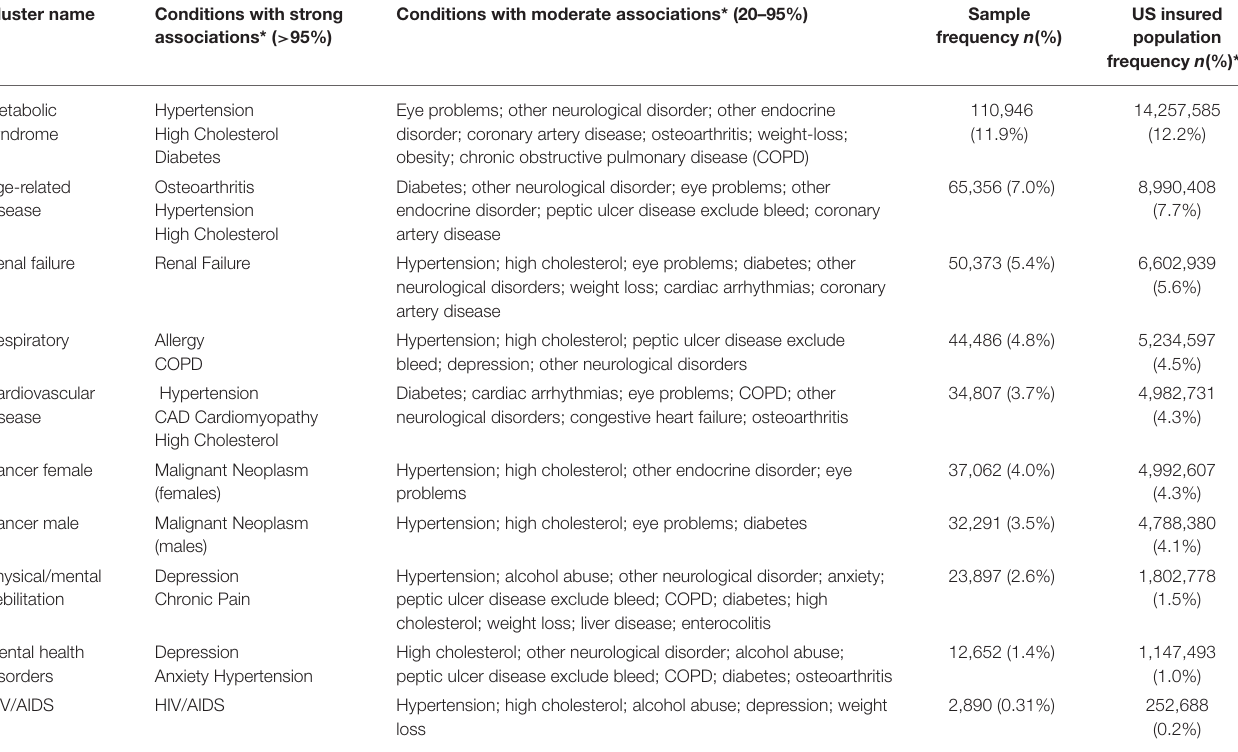
TABLE 2 | Key Clusters of chronic